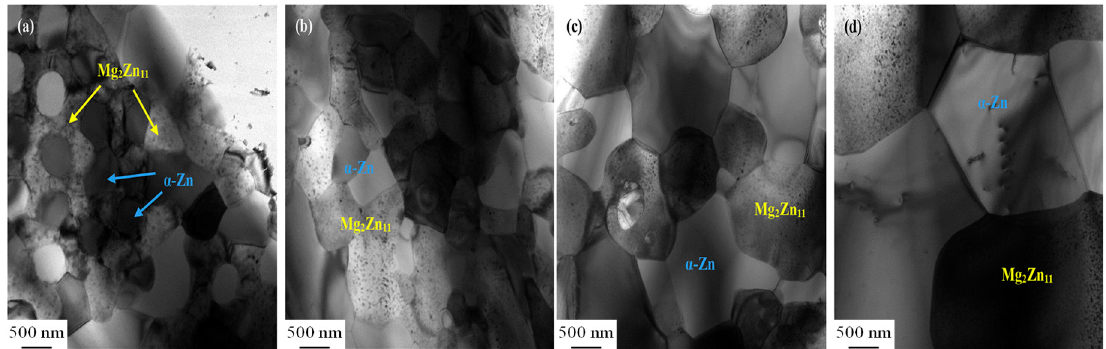
Figure 21. TEM images at different temperatures [126]: ( a ) 150 °C, 4 passes; ( b ) 150 °C, 12 passes; ( c ) 200 °C, 12 passes; ( d ) 250 °C, 12 passes. Reproduced with permission from Elsevier B.V. 200 ◦ C, 12 passes; ( d ) 250 ◦ C, 12 passes. Reproduced with permission from Elsevier